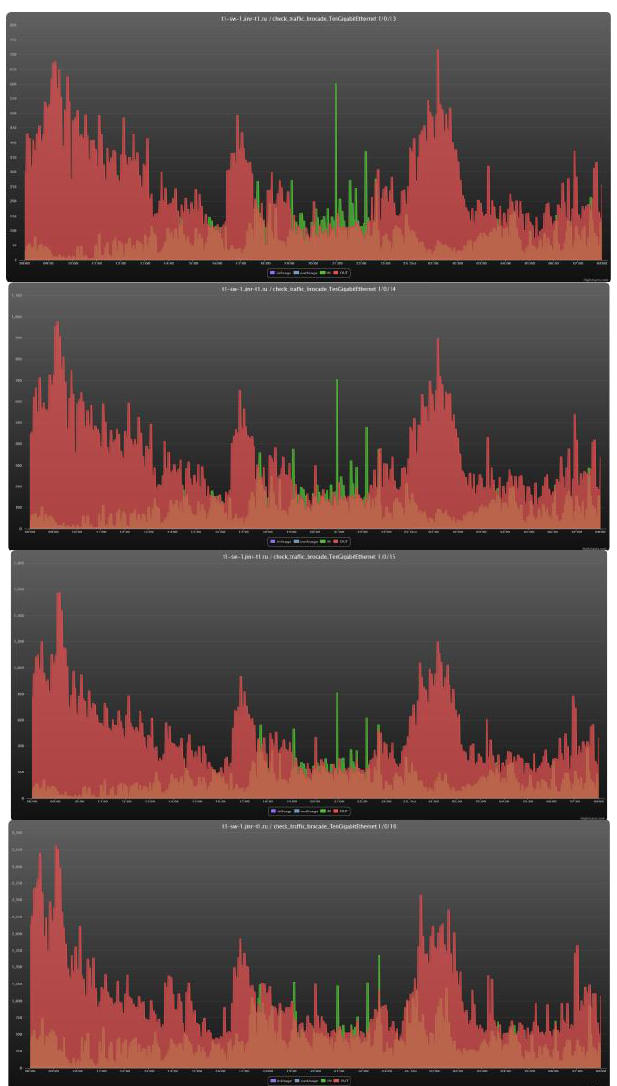
Fig. 7. Incoming/outgoing traffic of TenGigabit 013-016 network